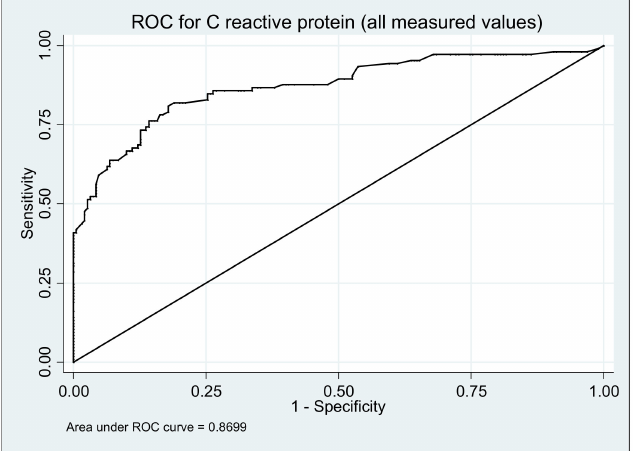
Figure 2. Area under the receiver operating characteristic (ROC) curve to predict ulcerative colitis relapse using C reactive protein determination during 12 months.